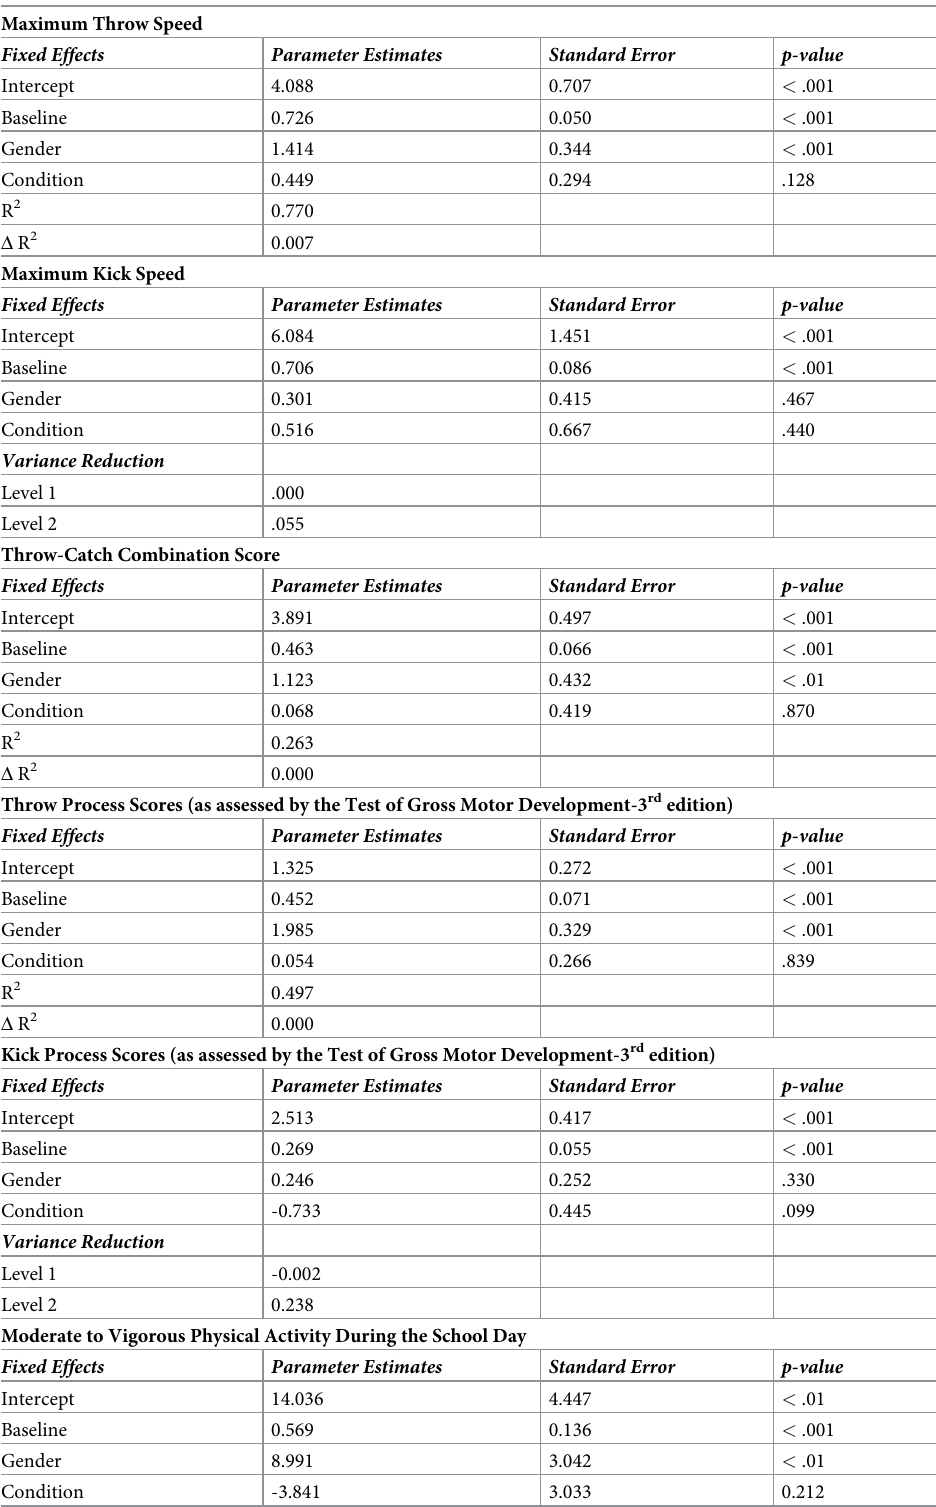
Table 5. Grade 3/4 FMS and physical activity